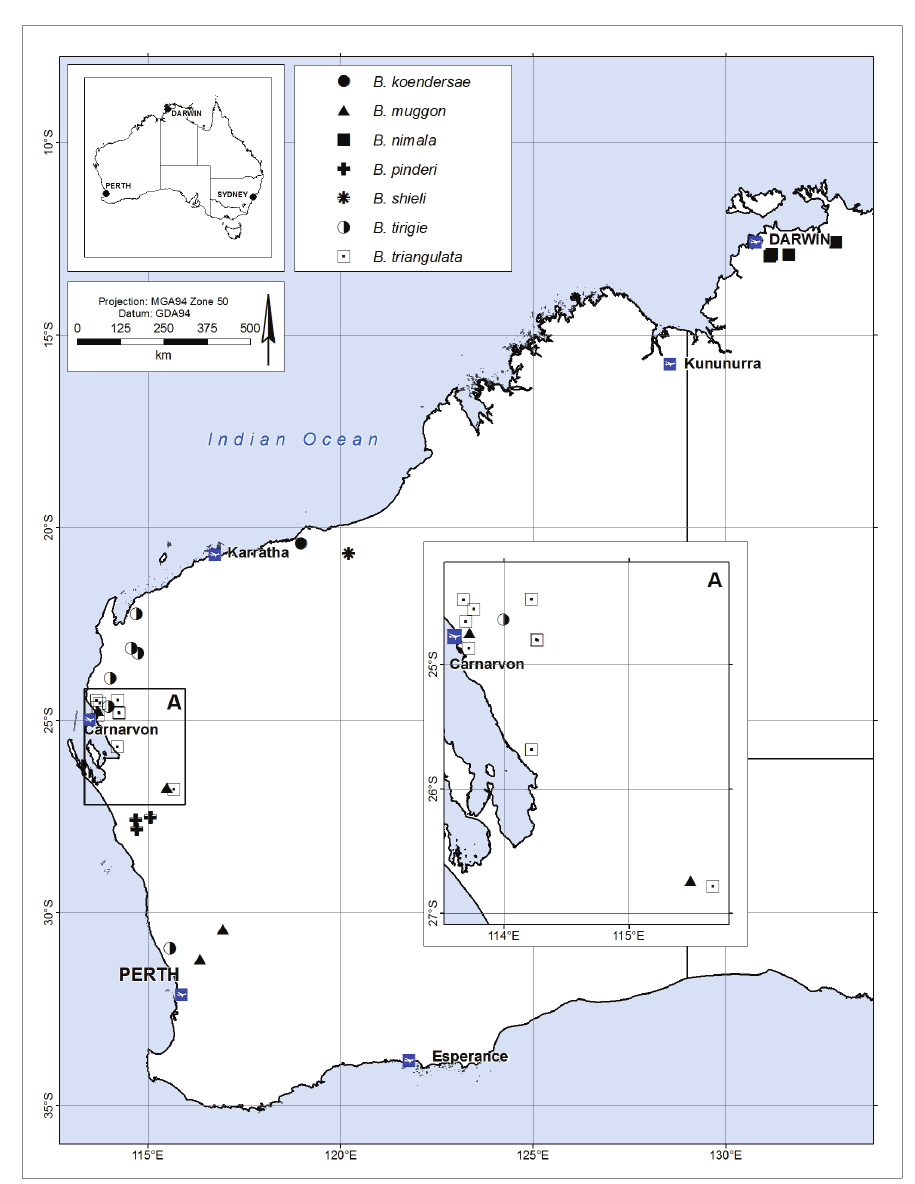
Fig. 1. Map of Western australia with localities of Bennelongia species described in the present